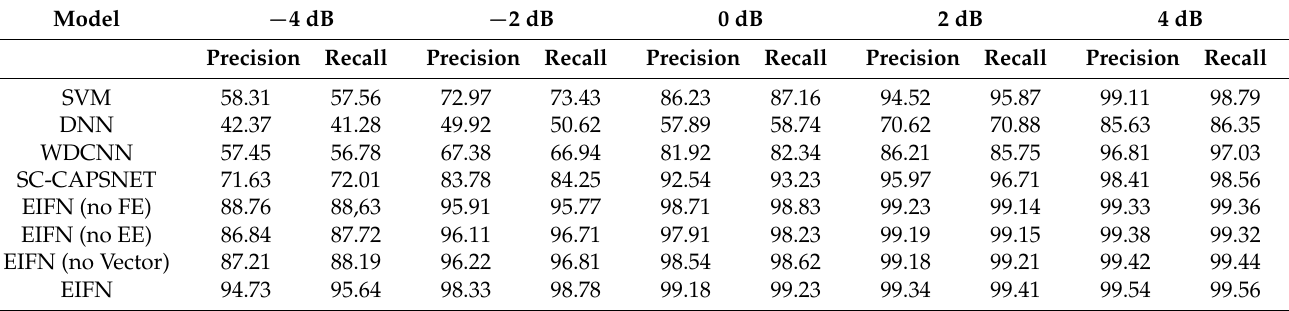
Table 5. Fault diagnosis results on CWRU.